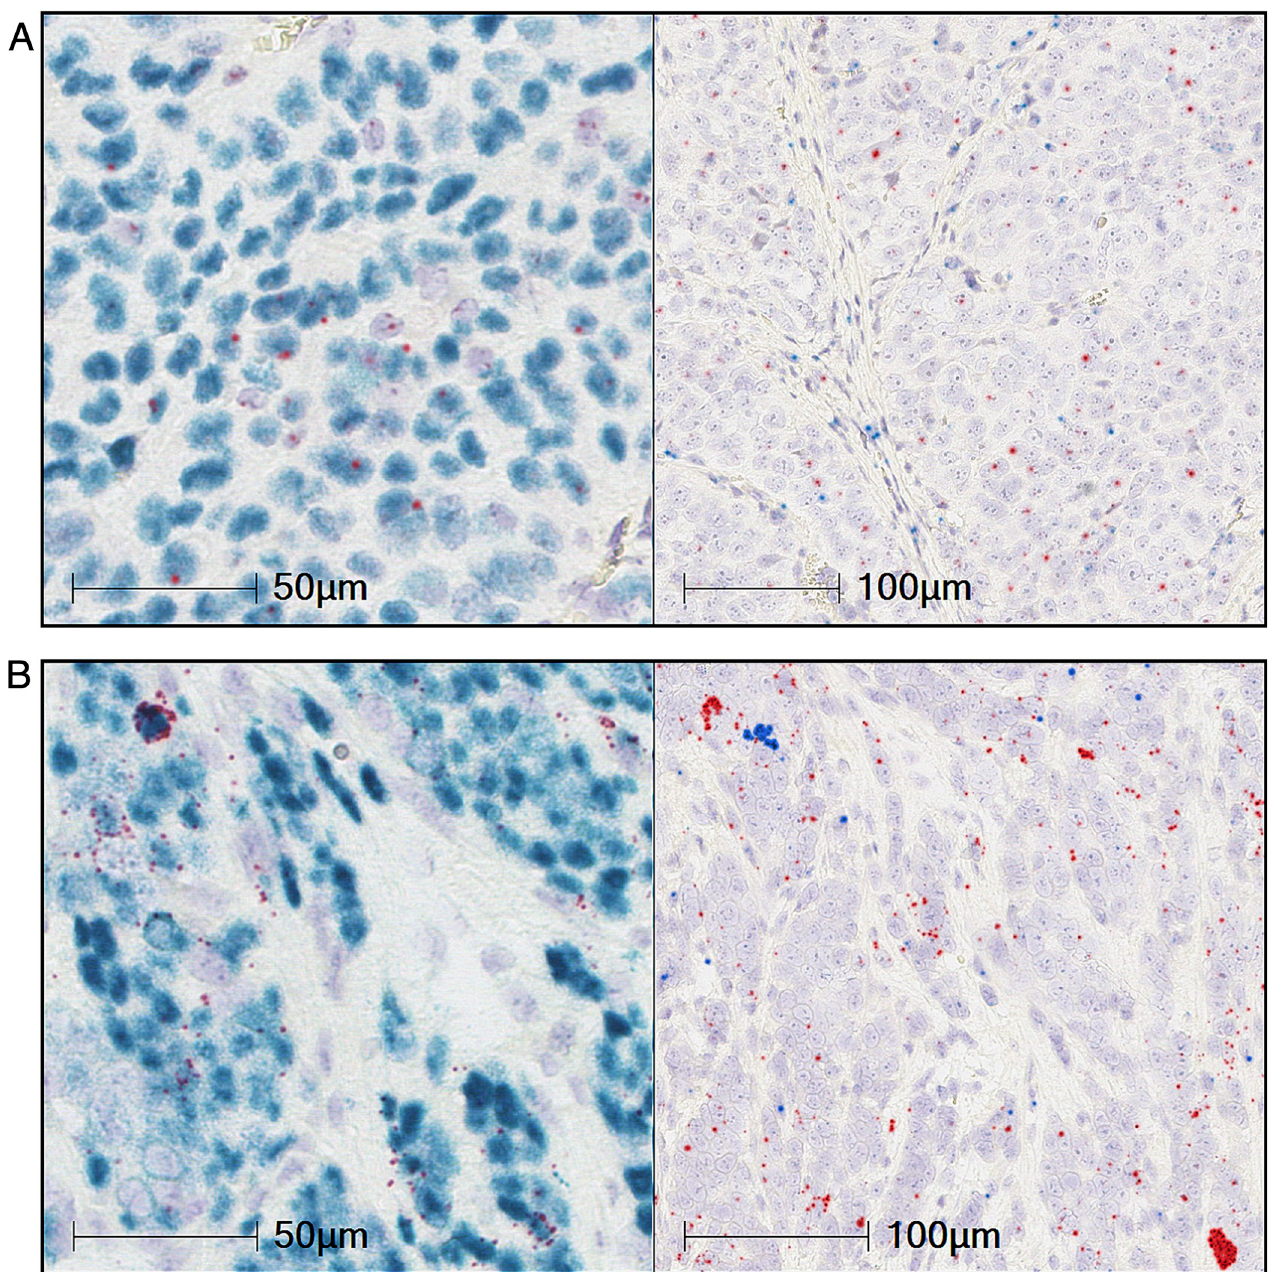
Fig 5. RNA ISH shows tumor-intrinsic and -extrinsic expression of CCL22 in Nasopharyngeal carcinoma xenografts. Representative images of RNA in situ hybridization (ISH) of a (A) C15 NPC xenograft and a (B) C666-1 NPC xenograft are shown. Left panels are EBER1 (cyan) and human CCL22 (red); right panels are mouse CCL22 (blue) and human CCL22 (red). Nuclear haematoxylin staining is shown in pale blue. Staining has been digitally enhanced for clarity (unenhanced images in S8A and S8B